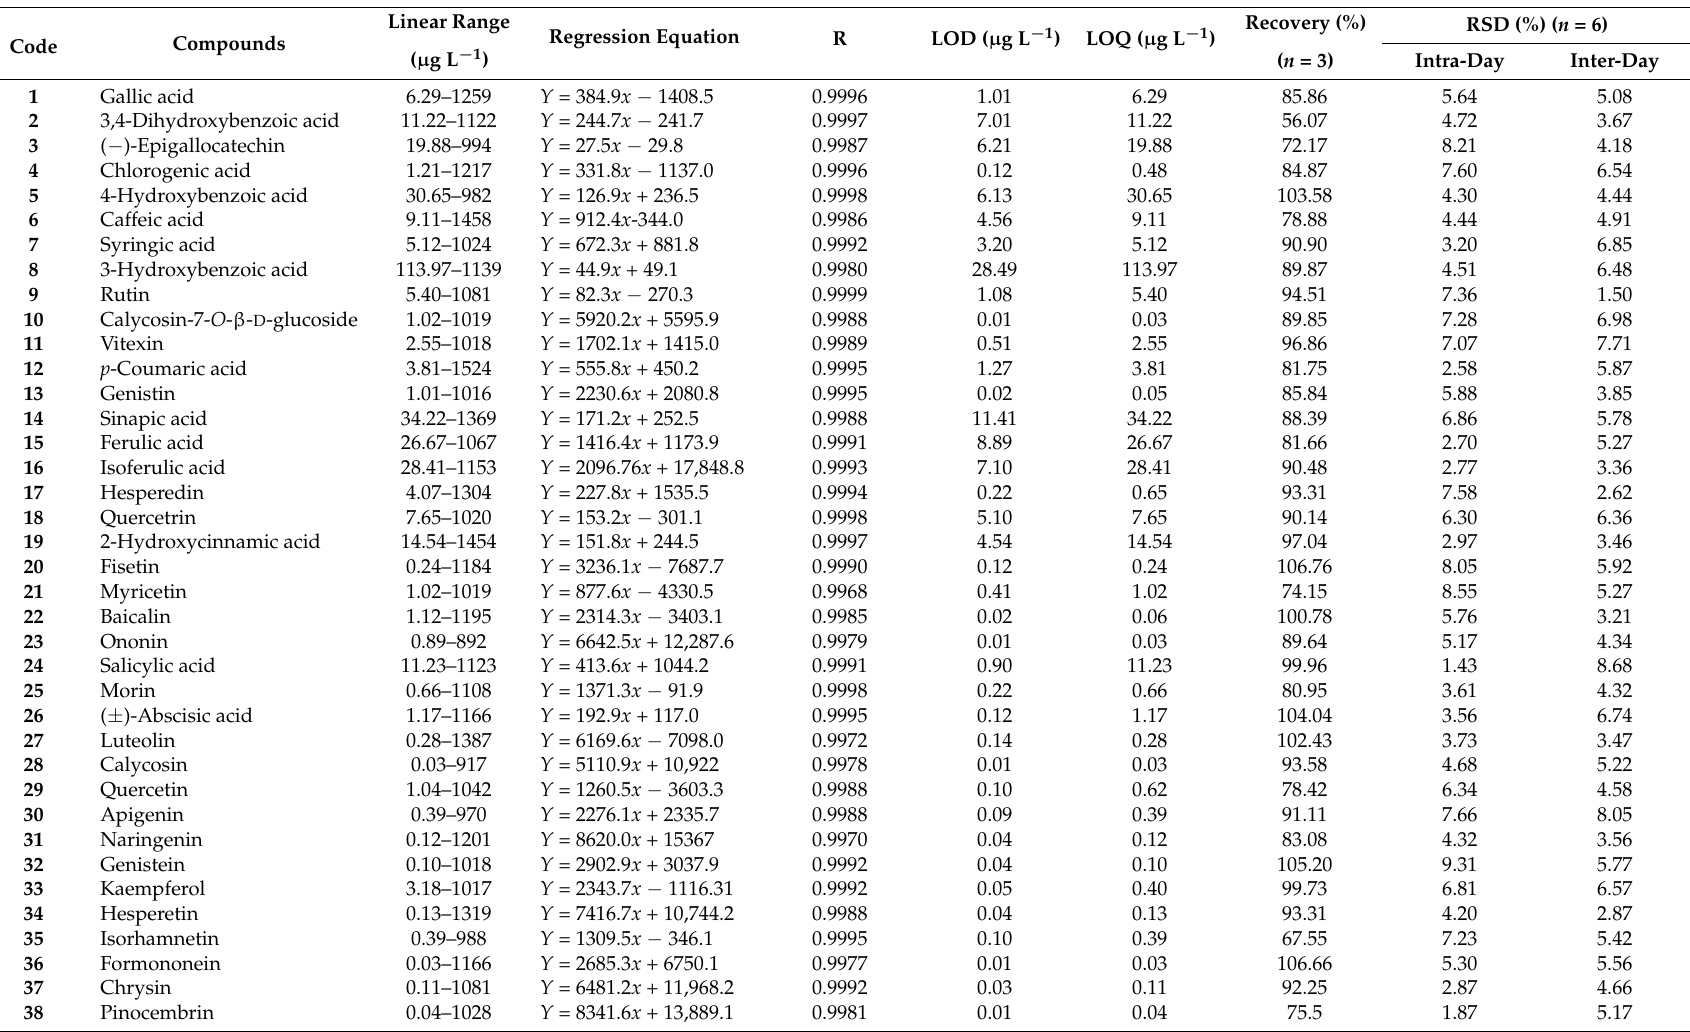
Table 2. Method validation results for each